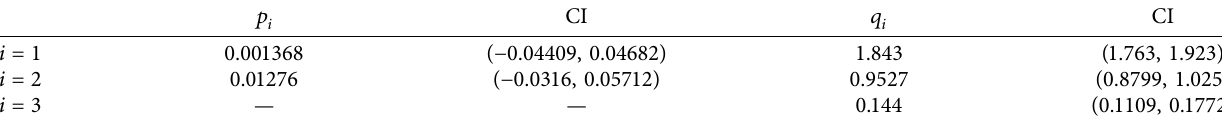
Table 22: Entropy vs. Re G